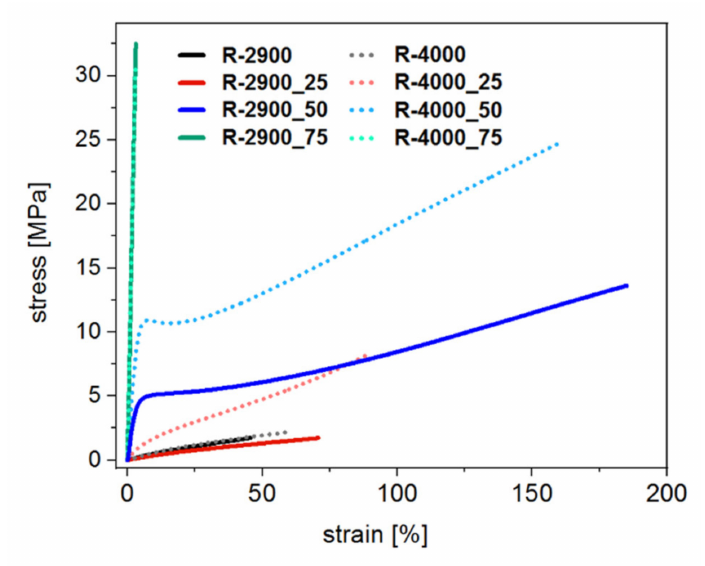
Figure 7. Exemplified stress vs. strain curves of polymers produced from the proposed FPP-resins. A substantial variation in mechanical properties is achieved through increasing copolymer